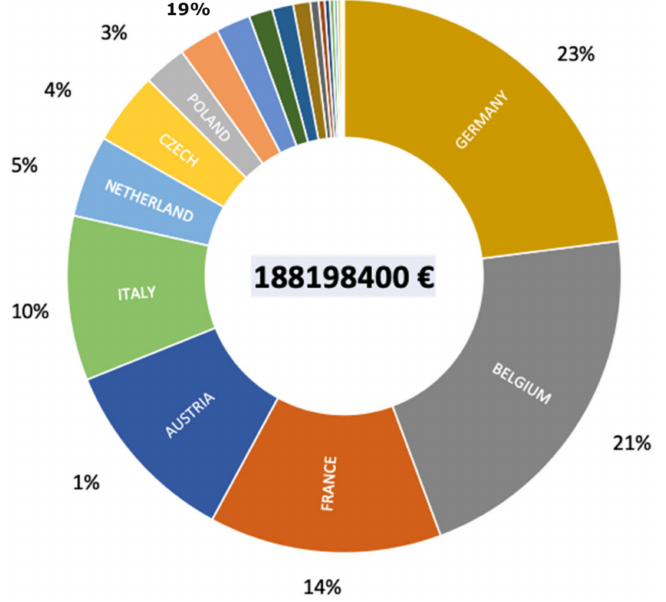
Figure 5. Total estimated cost in € for eradicating populations carrying the rosette agent Sphareothecum destruens in different European countries with a breakdown per country of this cost according to the number of populations present in each country (Britton et al., 2011,